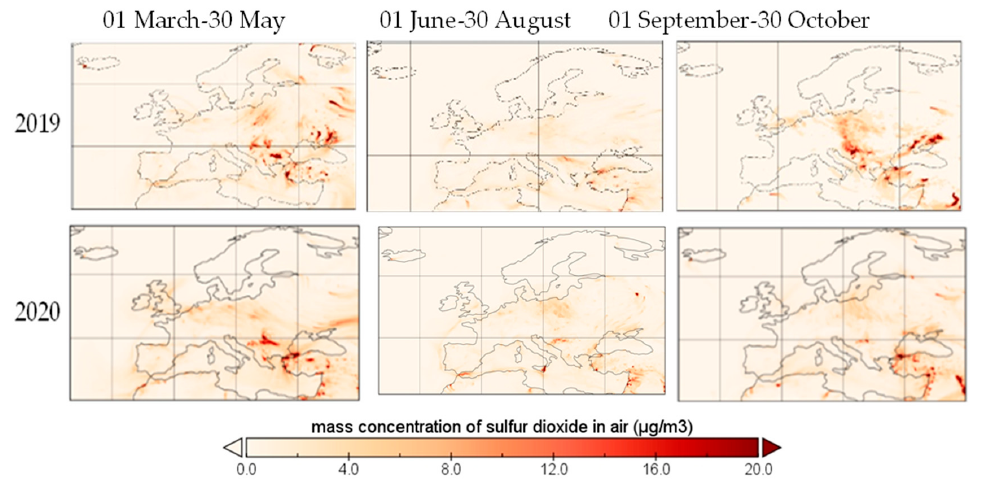
Figure 14. Sulfur dioxide over Europe during restriction period, 2020. Sulphur dioxide maintained the decreasing trend from spring to autumn 2020, in op- position with 2019, when the concentration presented a spike in autumn. Total precipita- tions were higher in October 2020 than in October 2019, so the concentration of SO 2 should be lower in 2020 than in 2019 (in the same period, as they are negatively associated with values ranging between − 0.378 and − 0.215 [16]). Among the health effects of SO 2 , irritation to the respiratory system, penetration deep into the lungs, the introduction of respiratory disease, bronchospasm/pulmonary edema, eye symptoms and cardiovascular disease were found in [32], while skin redness was mentioned in [33].